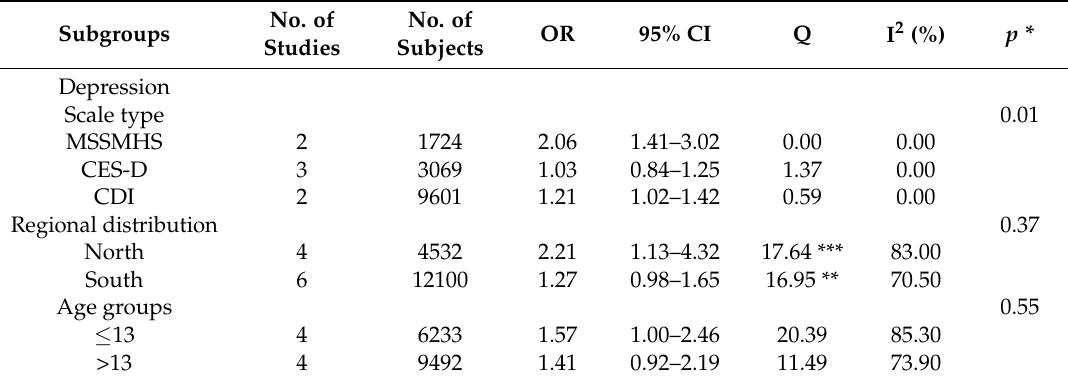
Table 4. Subgroup analyses of odds ratios of depression symptoms in children/adolescents with and without